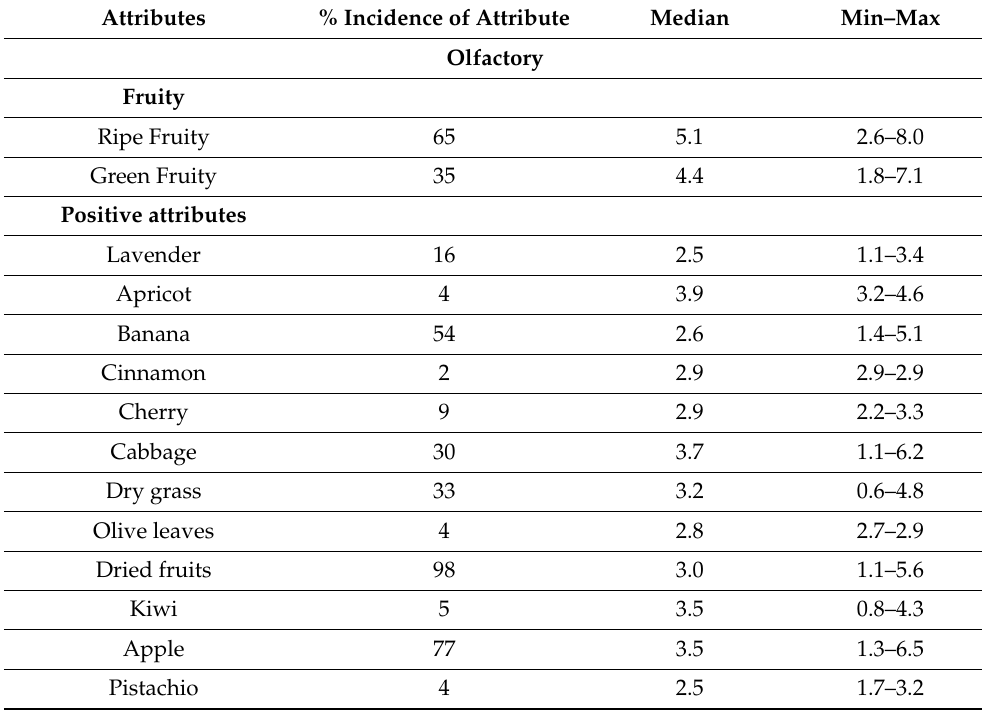
Table 2. Positive attributes detected in Douro extra virgin olive